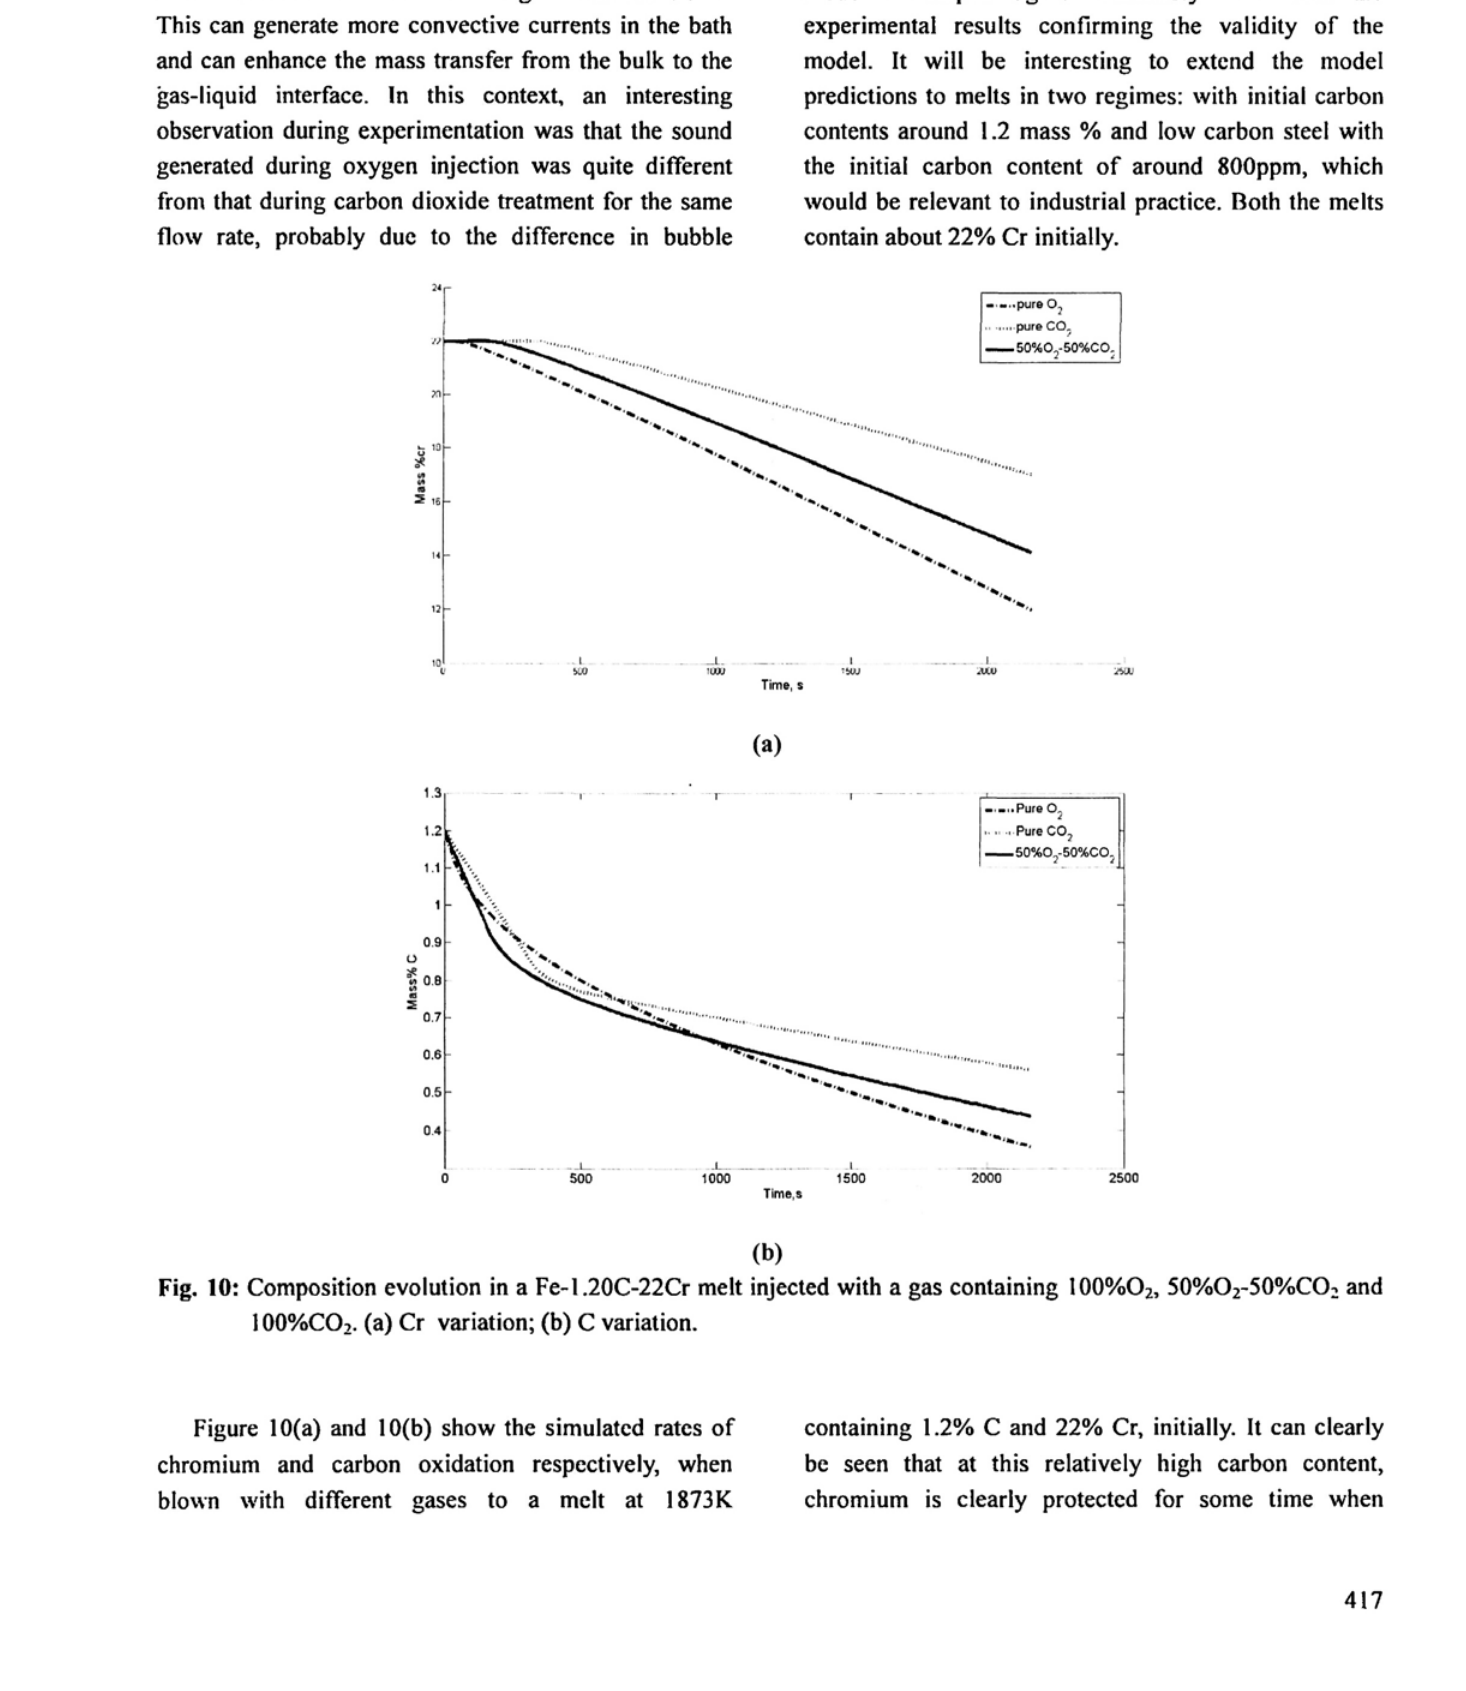
Fig. 10: Composition evolution in a Fe-1.20C-22Cr melt injected with a gas containing 100%O 100%CO . (a) Cr variation; (b) C 2